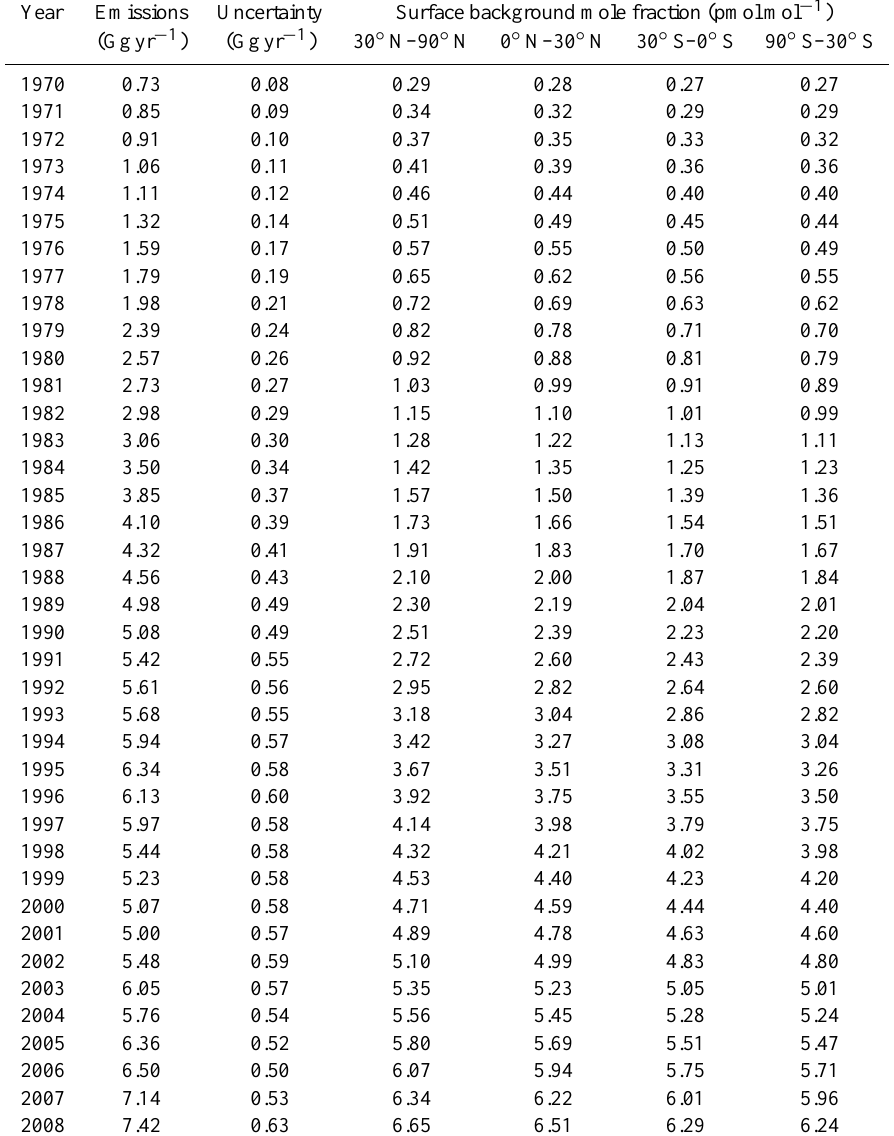
Table 2. Annual optimized emissions and associated uncertainty, and surface background mole fractions in each semi-hemisphere, 1970– 2008. Mole fractions are output from MOZART run with optimized emissions. Background values are defined as the median mole fraction of oceanic grid cells at the lowest model